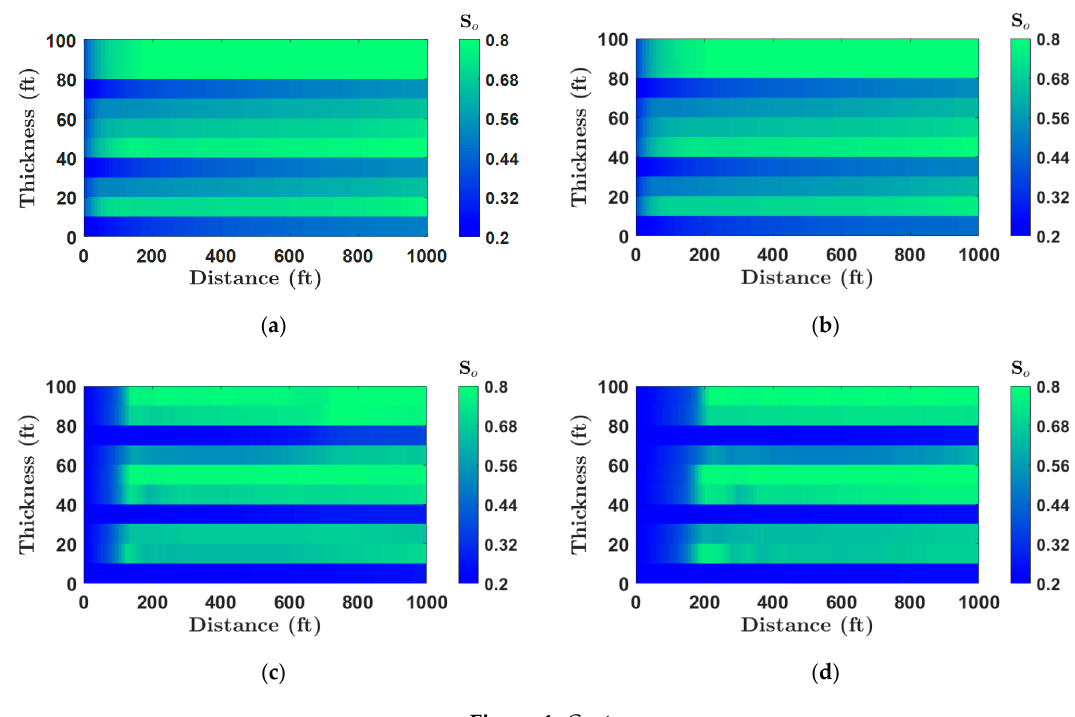
( e ) ( f ) Figure 4. Oil saturation profiles for the test case using waterflooding ( a , b ), continuous polymer flooding ( c , d ), and the compositionally-tuned slug-based process ( e , f ) at 1.3 D t = ( a , c , e ) and 1.7 D t = ( b , d , f ). ( a ) ( b ) Figure 5. Oil saturation profiles for the test case in layer nine ( a ), and layer eight ( b ) at 1.7 D t =